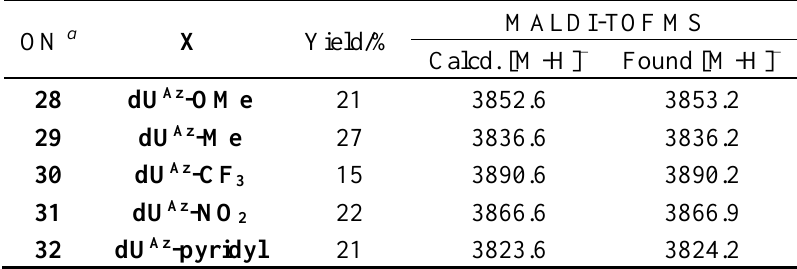
Table 1. Yields and MALDI-TOF MS data of dU Az -modified